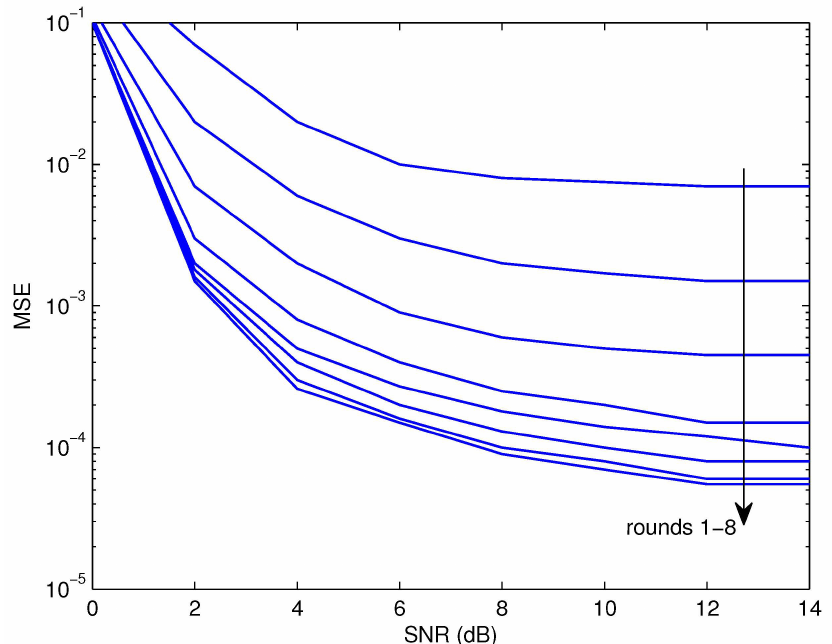
Figure 4. MSE performance of the proposed multiuser channel predictions. The system parameters are U = 4, N = 2048, (cid:104) Φ ( u ) (cid:105) = 512, u = 0,1,2,3, ν = 11, χ = 60, 10 channel paths, convolutional codes of rate 0.5, interleaved sub-carrier mapping, STBC set of S1, S2, S3, S4, S5, and modulation set of 4-QAM, 16-QAM, 64-QAM, 128-QAM, 256-QAM, and